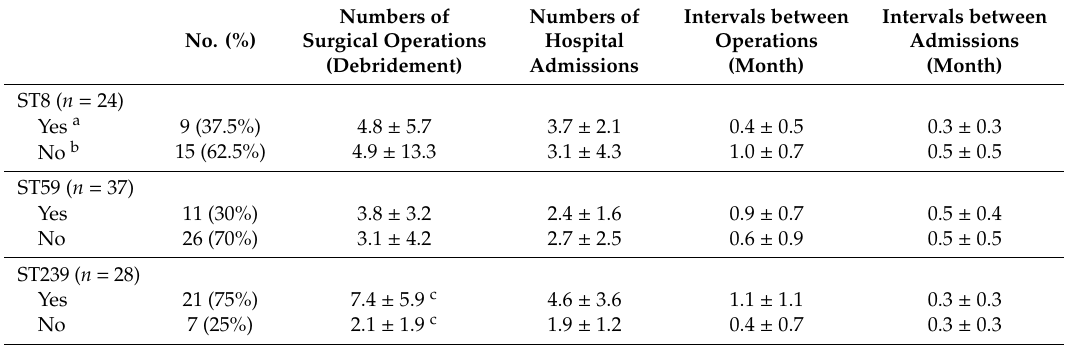
Table 9. E ff ect of chronic liver / kidney diseases on the morbidity of osteomyelitis caused by di ff erent MRSA